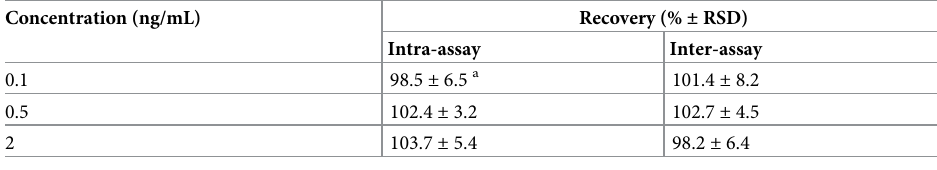
Table 4. Precisions of the proposed ELISA for CZT at different concentration levels.